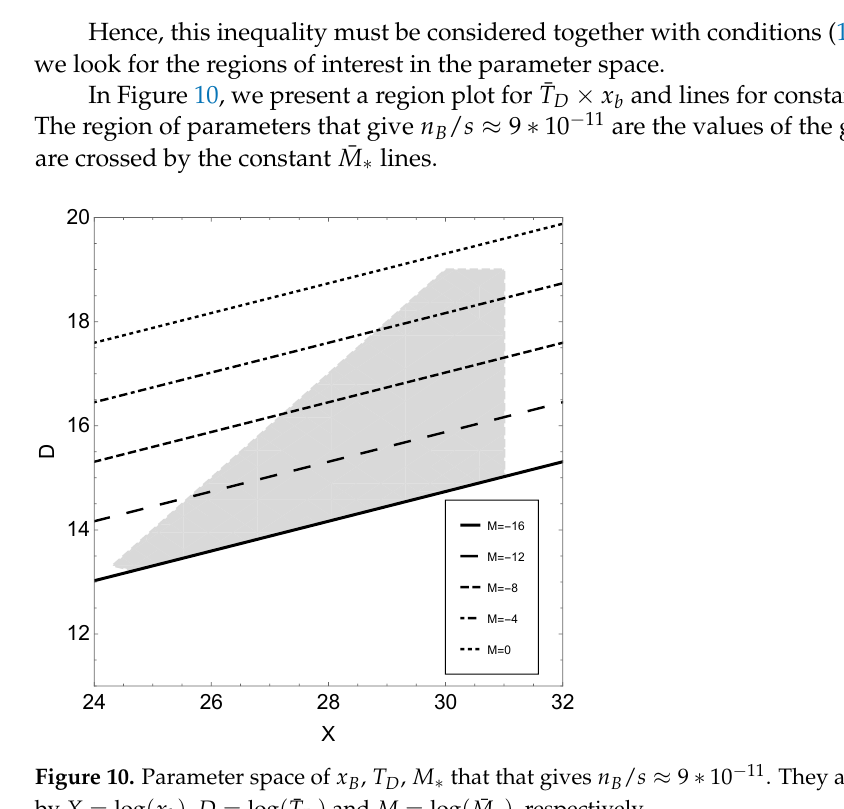
that that gives n B / s 9 10 − 11 . They are parameterized ≈ ∗ ∗ ) , ∗